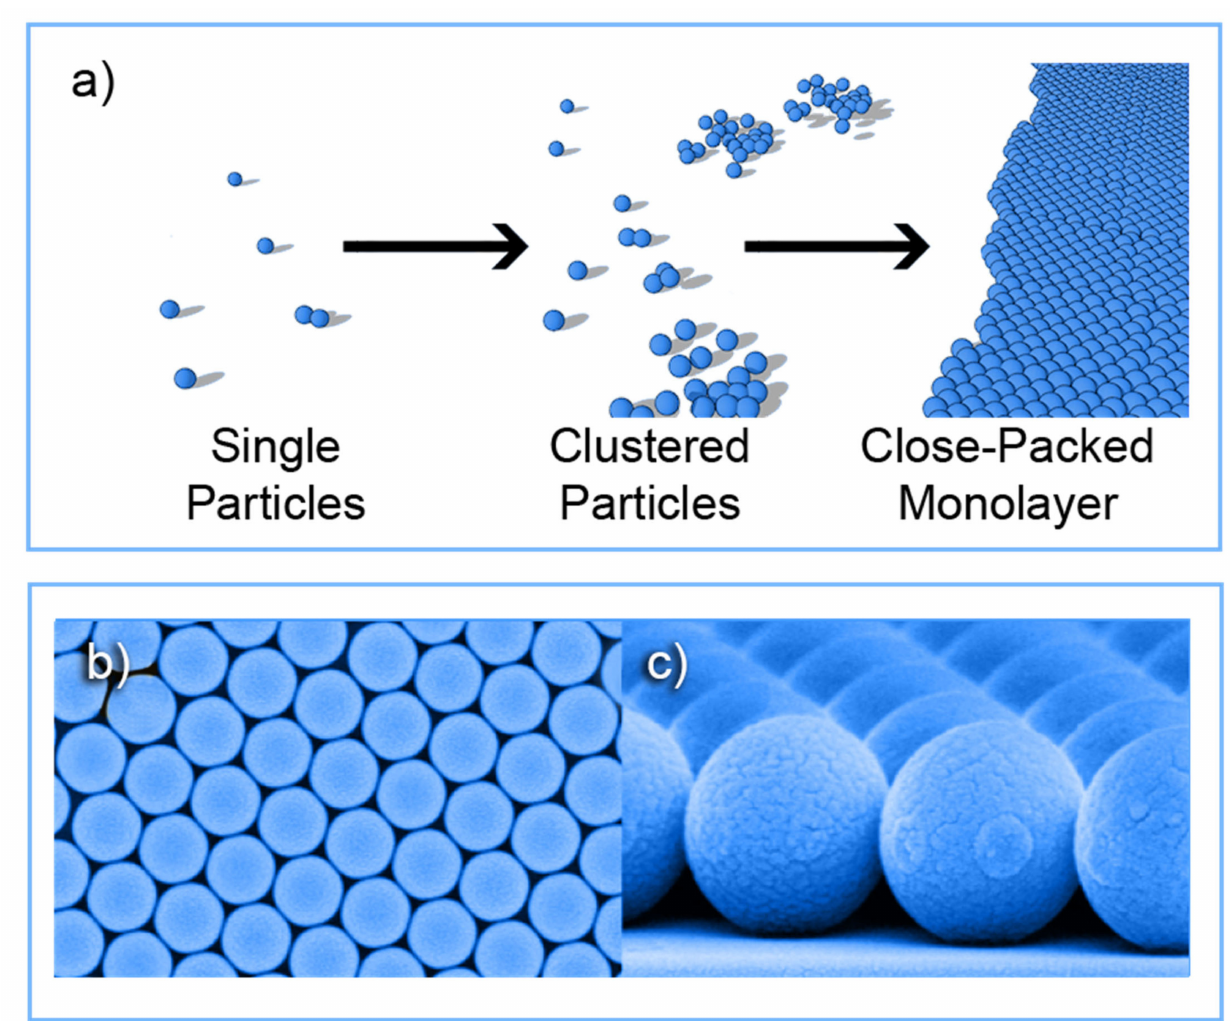
Figure 3. ( a ) Illustration of the self-assembly of colloidal particle structures forming a hexagonal close-packed array (also known as honeycomb), which results in the highest in-plane packing density; ( b ) Top-view and ( c ) cross-sectional scanning electron microscopy (SEM) images of honeycomb arrays of 800 nm PS spheres. Adapted with permission from [69]. Copyright 2021